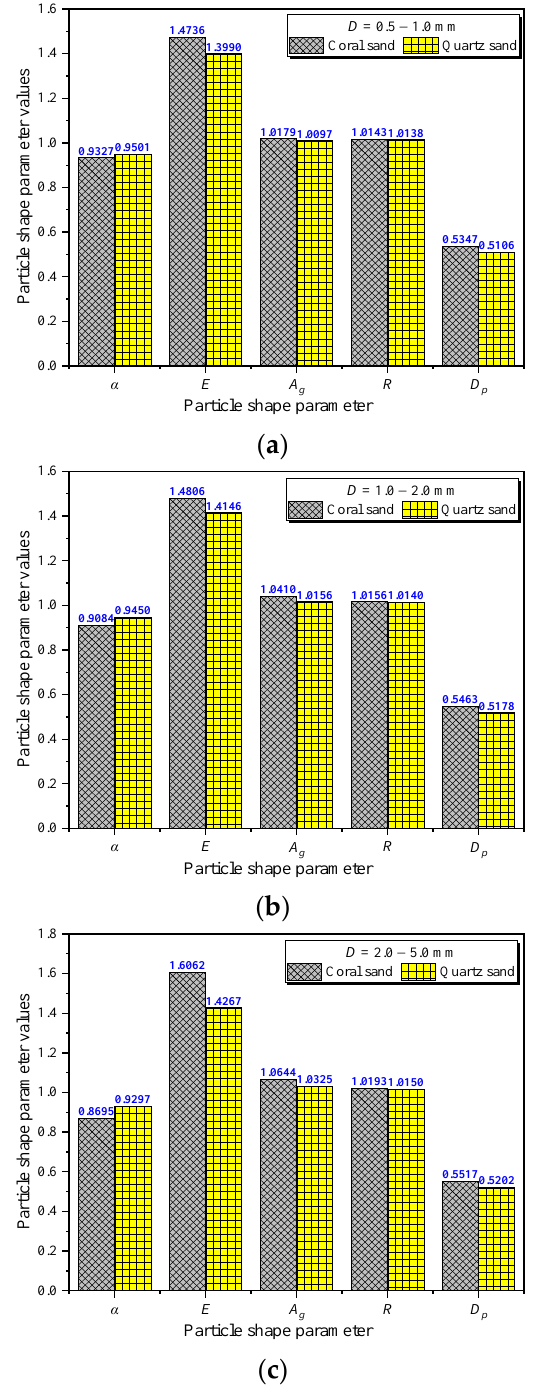
Figure 15. Comparison of shape parameters for coral sand and quartz sand with different particle sizes: ( a ) D = 0.5–1.0 mm, ( b ) D = 1.0–2.0 mm, and ( c ) D = 2.0–5.0 mm.